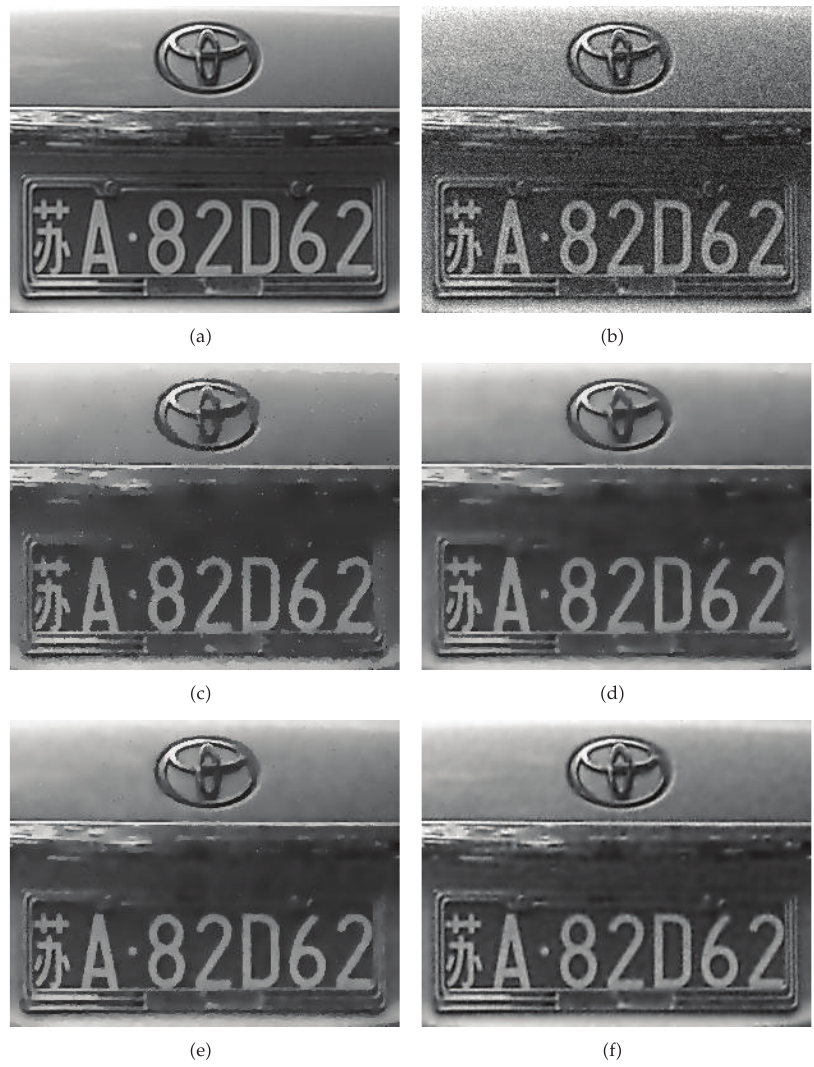
Figure 3: Comparison of di ff erent methods on “License plate” image. (cid:3) a (cid:4) Original image. (cid:3) b (cid:4) Noisy image. (cid:3) c (cid:4) PM smodel with k (cid:7) 10. (cid:3) d (cid:4) TDE model with k (cid:7) 10, λ (cid:7) 40. (cid:3) e (cid:4) ITDE model with k (cid:7) 10, λ (cid:7) 40,